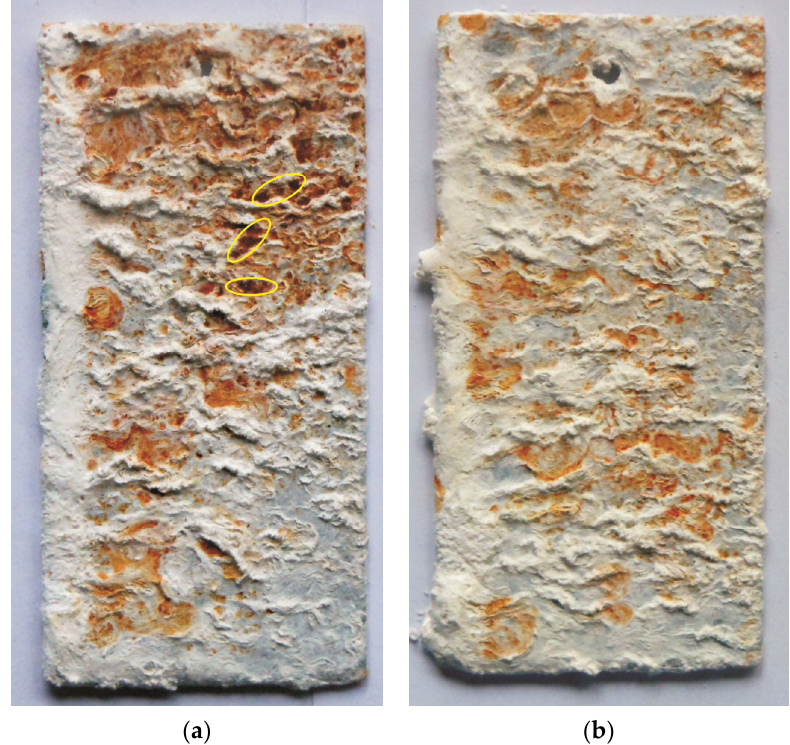
Figure 6. The view of the surface of: Zn-AlNiBi coating ( a ) and “pure” zinc coating ( b ) [17] after 1000 h of exhibition in a salt chamber.